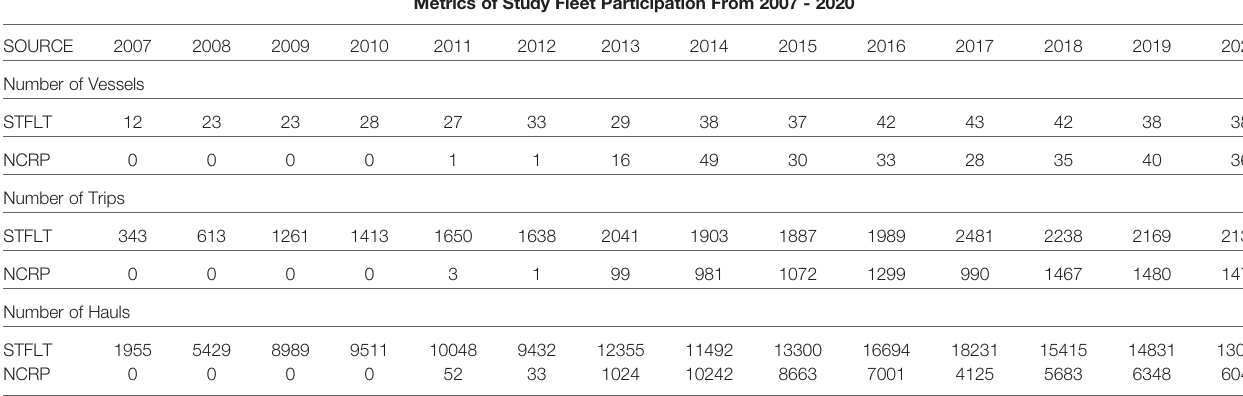
TABLE 1 | Metrics of study fl eet